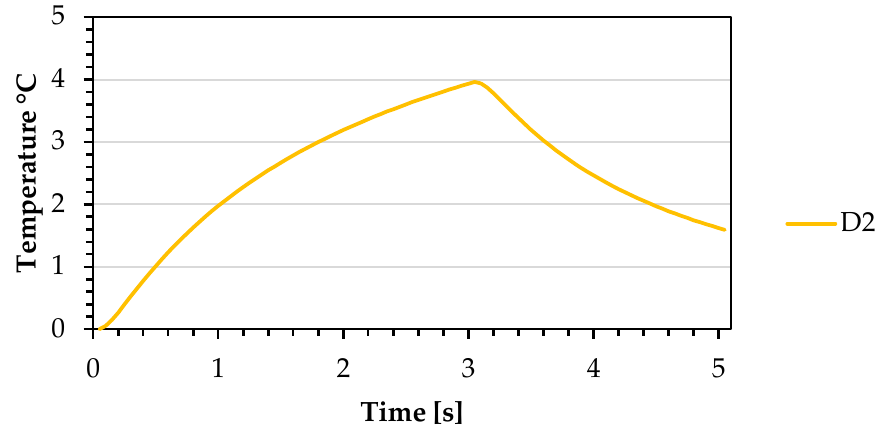
Figure 10. The course of temperature changes on the sample surface over the defects (location of the center of the vibration transducer x = 25, y = 55).